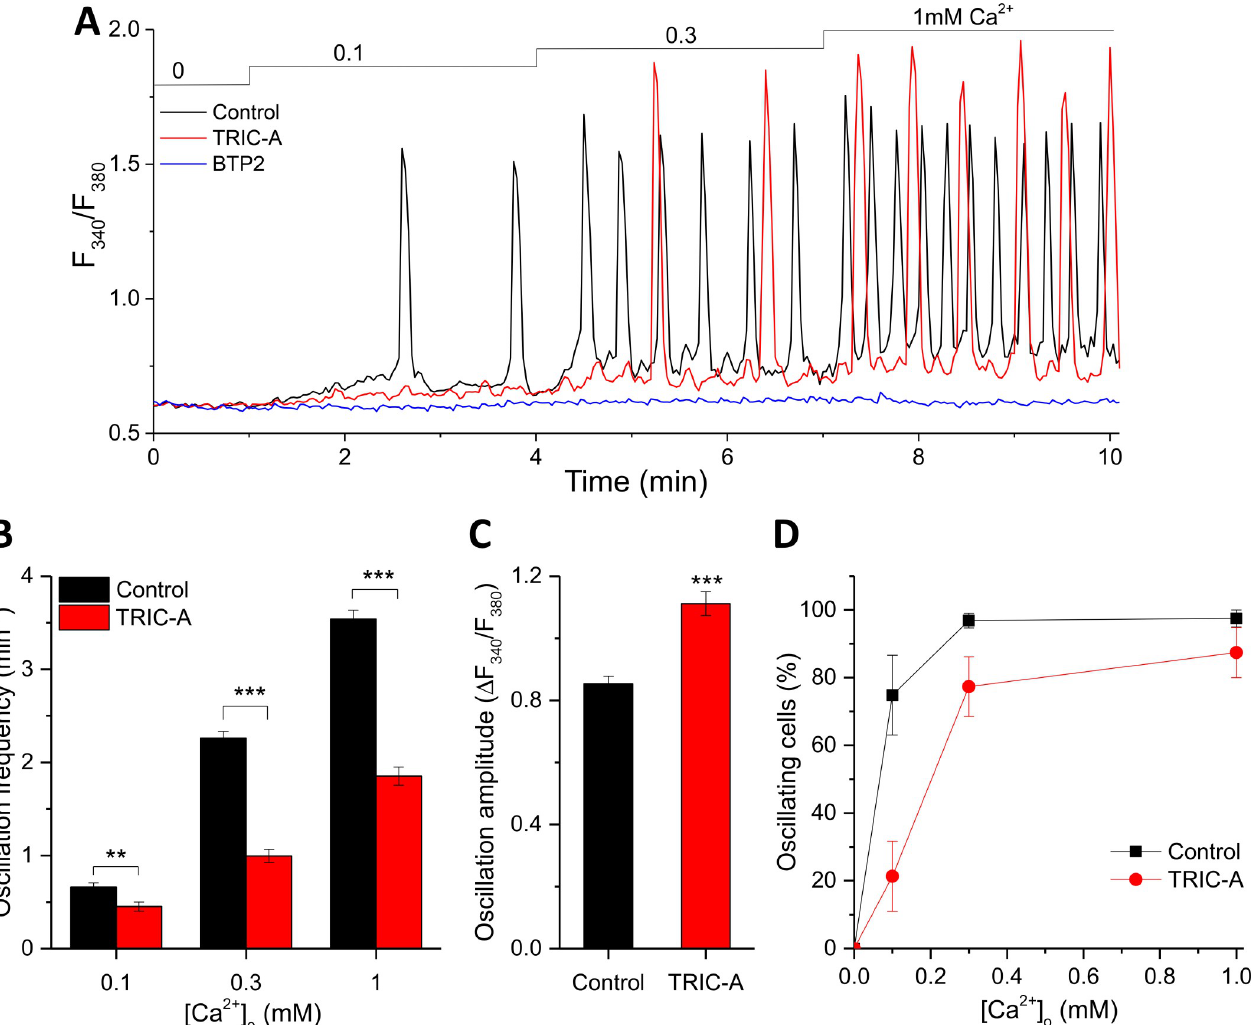
Fig 1. TRIC-A modifies the frequency and amplitude of RyR2-mediated cytosolic Ca 2+ oscillations. (A) Traces of cytosolic Ca 2+ -sensitive Fura-2 ratio, representing SOICR-associated oscillations in mCherry-ER-3– (control, black) or TRIC-A-mCherry–transfected (TRIC-A, red) HEK293_RyR2 cell and lack of oscillations in 3 μ M BTP2-incubated (BTP2, blue) control cell. (B) Ca 2+ oscillation frequency at 0.1, 0.3, and 1 mM [Ca 2+ ] o , (C) amplitude at 1 mM [Ca 2+ ] o , and (D) proportion of oscillating cells in TRIC-A cells ( n = 88) versus controls ( n = 81); �� p < 0.01, ��� p < 0.001; mean ± SEM values are shown. Underlying data in panels (A–D) are included in S1 Data. BTP2, N-[4-[3,5-Bis(trifluoromethyl)pyrazol-1-yl]phenyl]-4-methylthiadizole-5-carboxamide; ER, endoplasmic reticulum; Fura-2, cytosolic Ca 2+ -sensitive fluorescent indicator; HEK293, human embryonic kidney 293; RyR, ryanodine receptor; SOICR, store-overload– induced Ca 2+ release; TRIC, trimeric intracellular